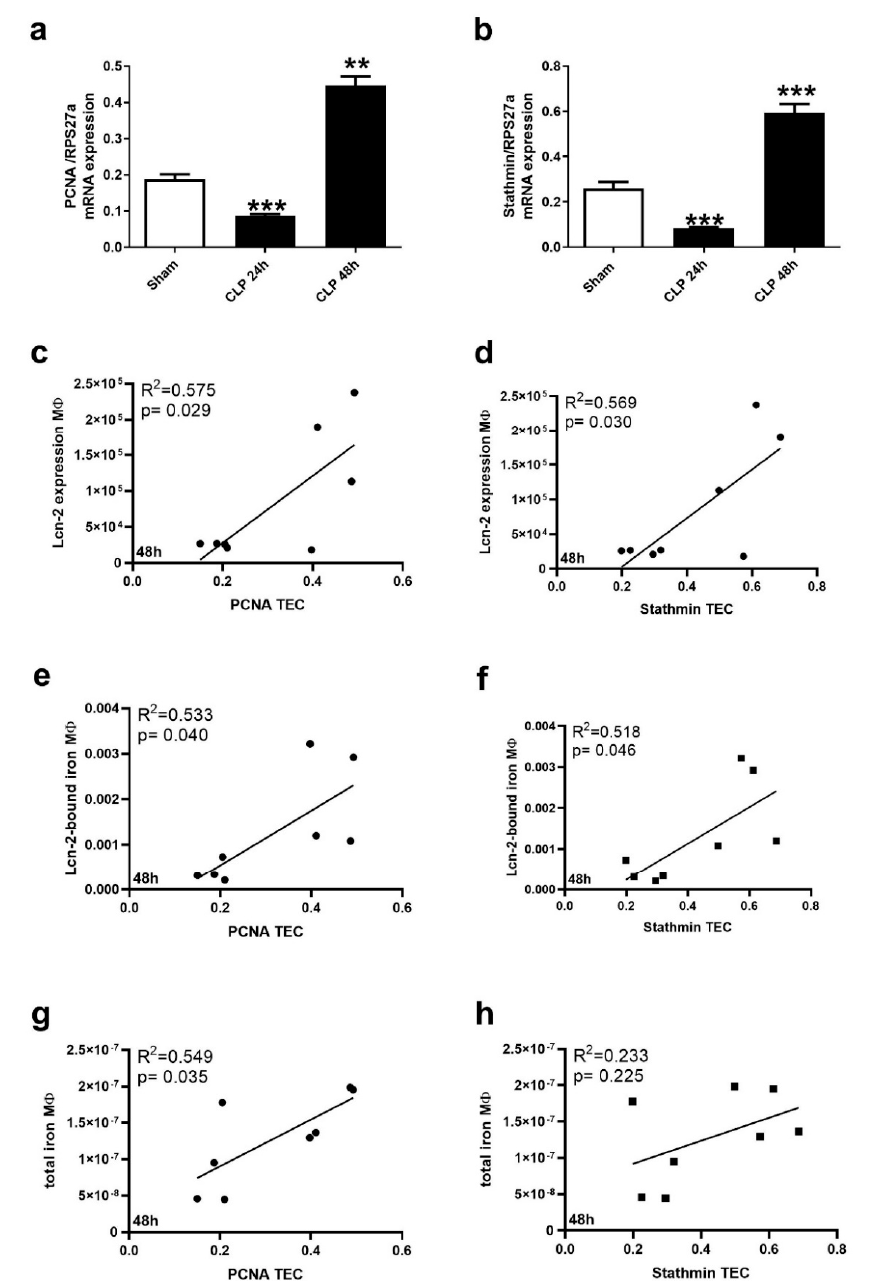
Figure 5. Renal recovery correlates with both total iron as well as Lcn-2-bound iron from renal M Φ . mRNA expression of ( a ) PCNA and ( b ) Stathmin relative to the housekeeping gene RPS27a. n = 5 animals per group. ** p < 0.01, *** p < 0.001; one-way ANOVA followed by Tukey’s